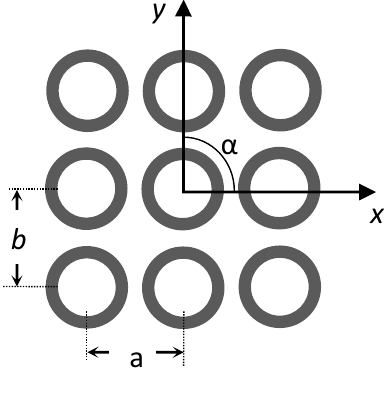
Figure 1. Arrangement of basic FSS elements.